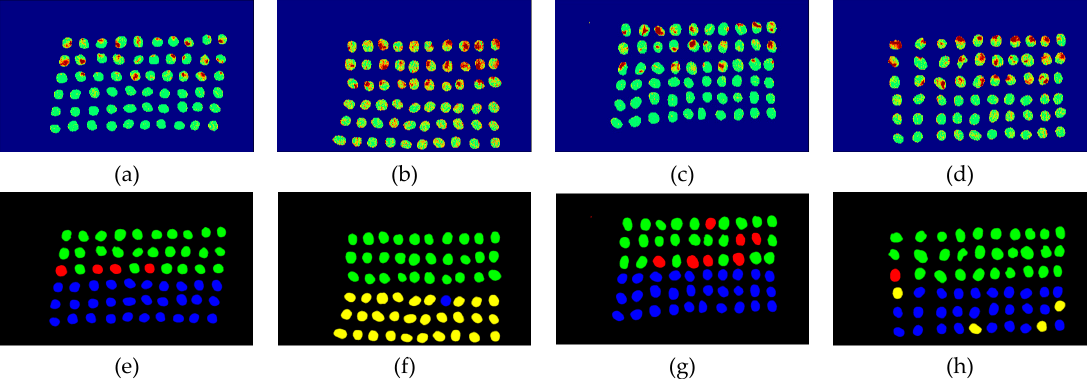
Figure 41. Results of green coffee bean CEM-SVM+SF_CTBS 20 bands. (a-d) SVM classification results, (e-h) final visual images.